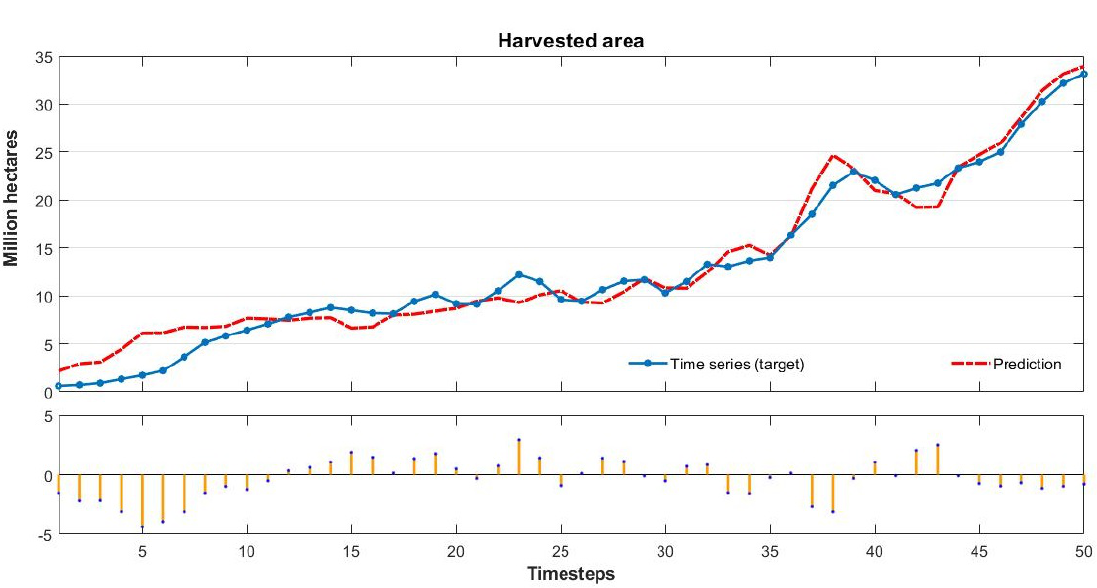
Figure 10. Multistep prediction of harvested area using Matlab R2017b.